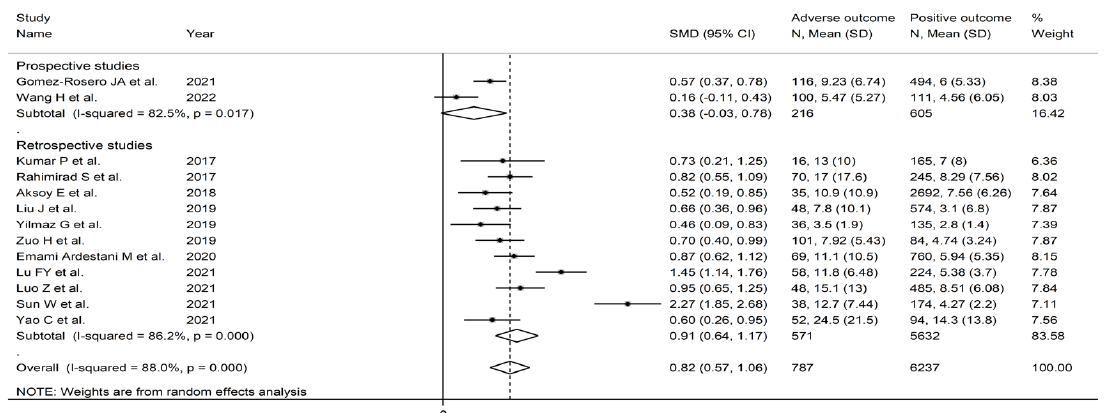
Figure 13. Forest plot of the association between the neutrophil-to-lymphocyte ratio, using standard mean differences, and adverse outcomes according to study design (prospective vs. retrospective). p = 0.000 indicates a p -value < 0.001.